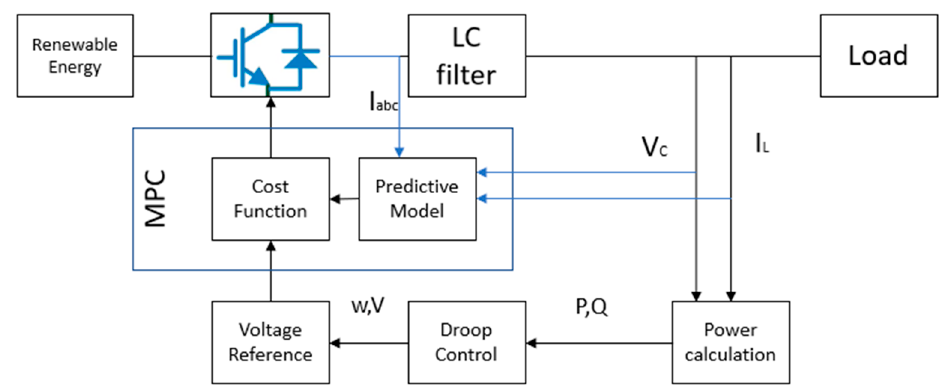
Figure 12. Sample architecture of multiagent control in a microgrid.